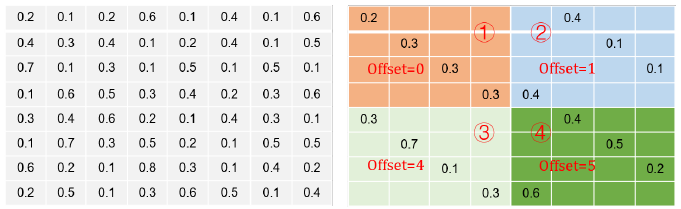
Figure 4. ( a ) An original weight matrix in high density. ( b ) Pruned by a permuted block-diagonal mask matrix with p =